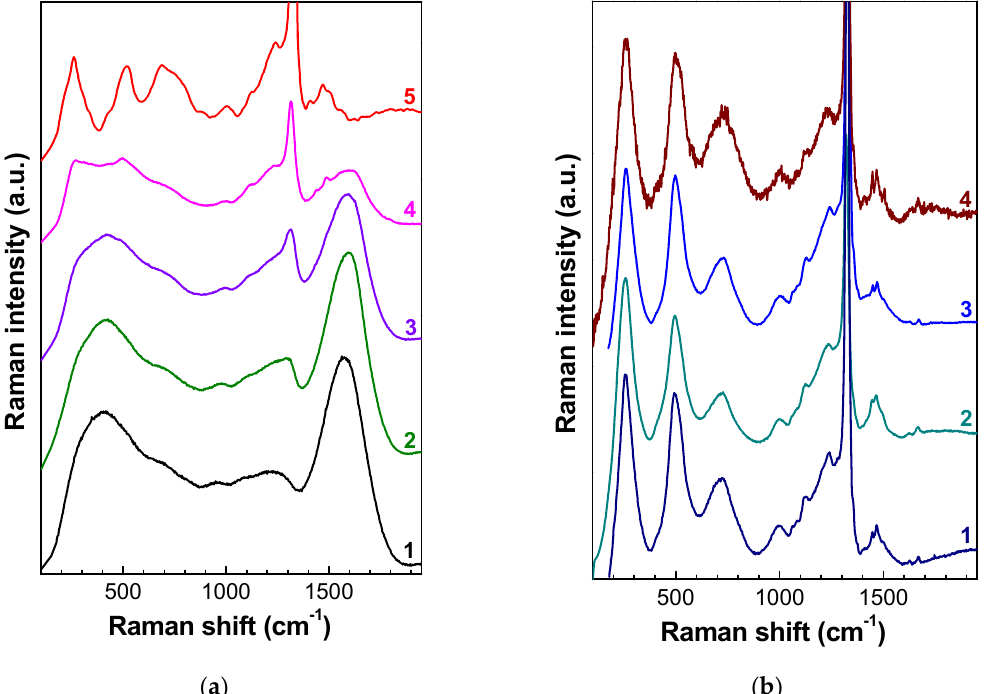
Figure 3. ( a ) Transformation of the Raman spectra of natural diamond irradiated with fast neutrons with fluence of 3 × 10 20 cm -2 and annealed at (1) 100 °C, (2) 600 °C, (3) 810 °C, (4) 910 °C, and (5) 1310 °C. ( b ) Raman spectra of neutron-irradiated diamond and annealed at T ann diamonds: (1) F = 2 × 10 19 cm −2 , T ann =1005 °C; (2) F = 1 × 10 20 cm −2 , T ann = 1125 °C; (3) F = 1×10 19 cm −2 , T ann = 1175 °C; and (4) F = 2 × 10 20 cm −2 , T ann = 1150 °C. The spectra are vertically shifted for clarity.